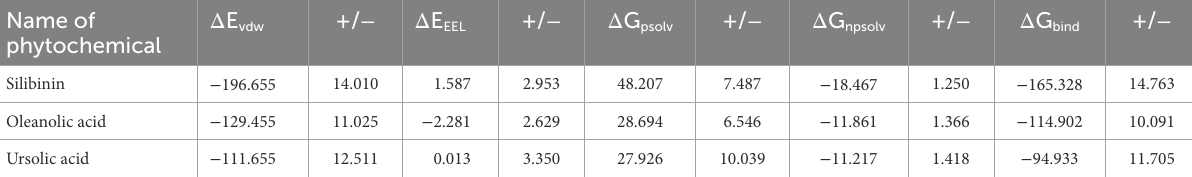
TABLE 4 Summary of energy components from MM/PBSA analysis of the lead phytomolecules with the H3 protein. Name of